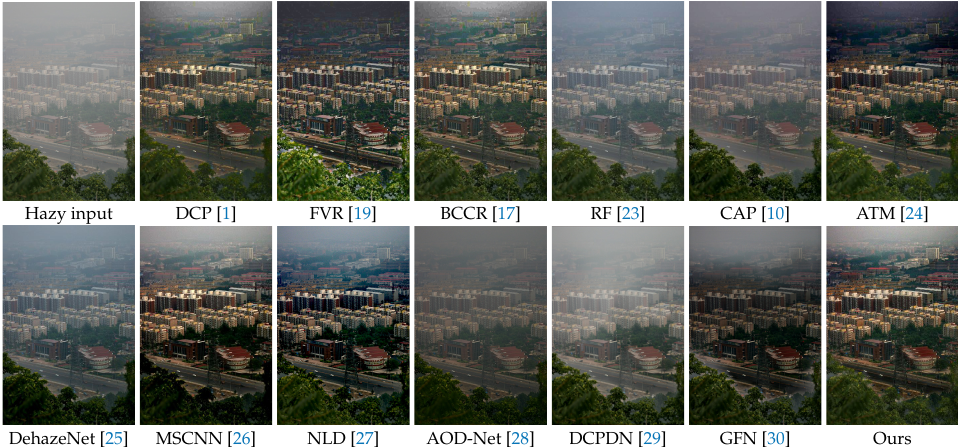
Figure 10. The dehazing result of the proposed method and state-of-the art methods on the real hazy images. The proposed method generates much clearer images with clearer structures and characters.